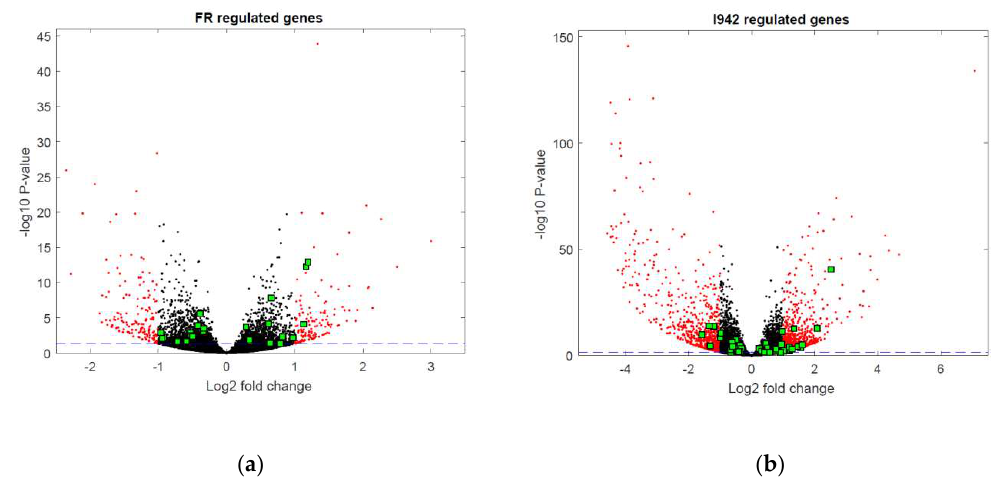
Figure 5. The RNA-SEQ data generated for Figure 1 was re-analysed to identify changes in the expression of 84 genes in ( a ) F/R and ( b ) I942 treated cells, which were previously identified as being specifically associated with endothelial cell function (green squares). Gene identities include those associated with angiogenesis, vasoconstriction/dilation, inflammation, apoptosis, cell adhesion, coagulation and platelet aggregation [35] and are subsequently used in Figure 6 for RT-PCR experiments.